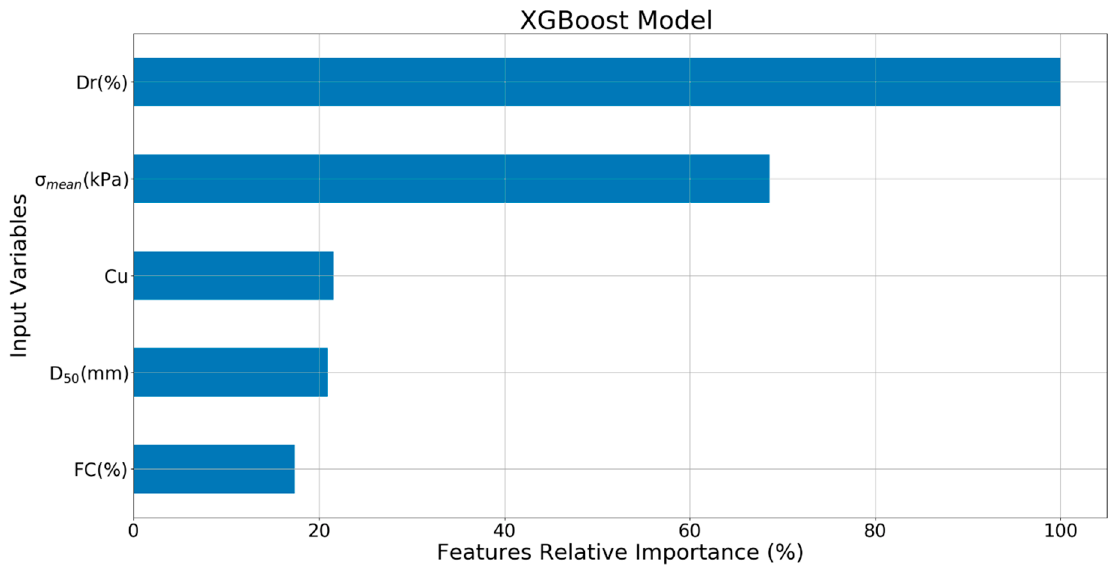
Figure 27. Relative importance of the input variables for the developed XGBoost model.